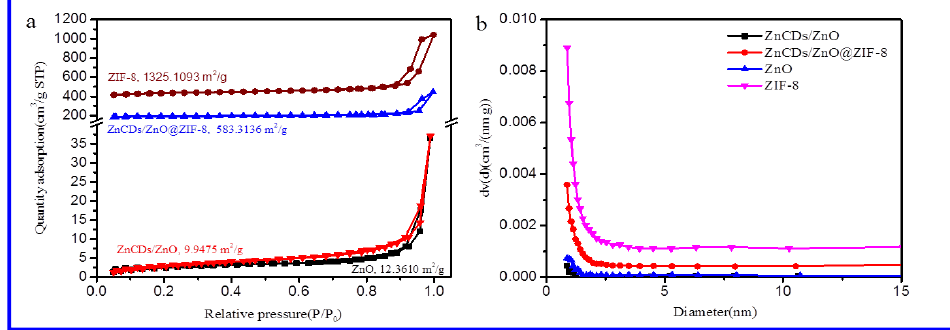
Figure 5. ( a ) Nitrogen adsorption − desorption isotherm ( b ) BET of ZnCDs/ZnO@ZIF-8. Figure 5a shows the nitrogen adsorption − desorption isotherms of ZnCDs/ZnO@ZIF-8 and related materials ZnO, ZnCDs/ZnO, and ZIF-8. The curves of ZIF-8 are a typical type I nitrogen adsorption − desorption isotherm [39], which fit well with the microporous frameworks of ZIF-8. The curves for ZnCDs/ZnO are a type IV isotherm [39], which shows low adsorption at low pressure and multilayer adsorption at high pressures owing to slits caused by assembly of ZnO. The specific BET surface area is 9.94 m 2 /g. For comparison, the BET surface area of ZnCDs/ZnO@ZIF-8 is 583.3 m 2 /g, higher than that of ZnCDs/ZnO. The initial adsorption of ZnCDs/ZnO@ZIF-8 is higher than that of ZnO, indicating that micropores exist in ZnCDs/ZnO@ZIF-8, which can be attributed to the frameworks of ZIF-8. The multilayer adsorption at high pressure corresponds to spherical morphology of the sample, similar to that of ZnO [21]. Figure 5b summarized pore size distribution by BJH method [40]. It indicates that the pore size of ZnCDs/ZnO@ZIF-8 distribution is wide.